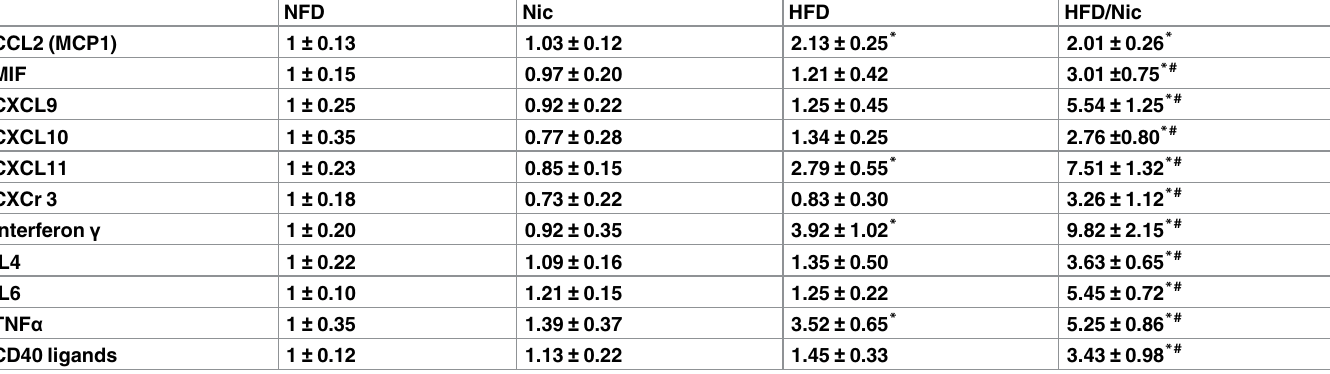
Table 2. mRNA profile of inflammatory cytokines in the aorta of nicotine-treated obese rats (data was normalized by NFD group as 1, determined by PCR array).